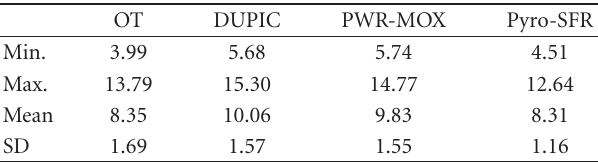
Figure 4: Share of spent fuel treatment techniques in the LFCC. Table 4: Results of a Monte Carlo simulation for the uncertainty analysis of LFCCs.